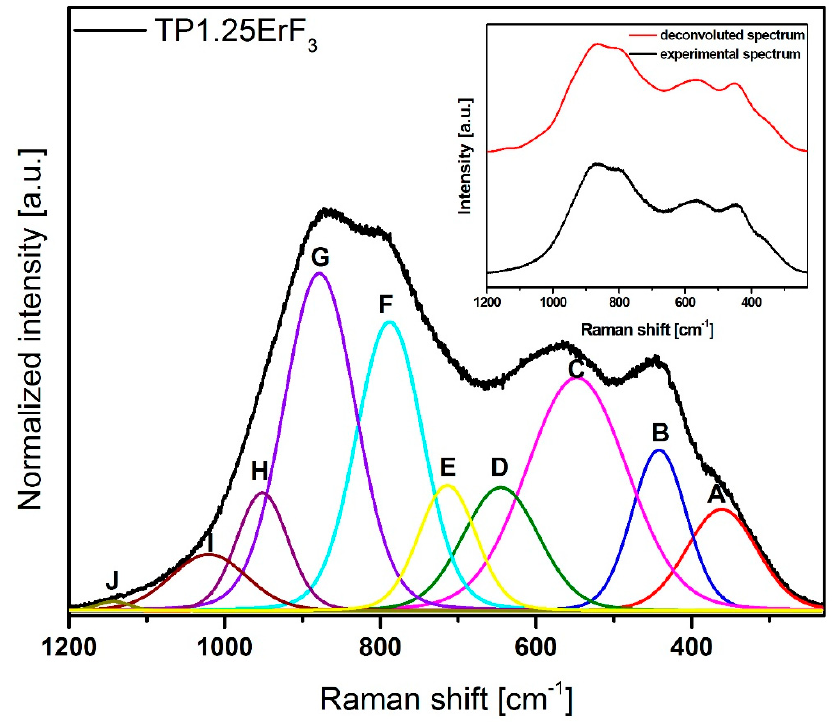
Figure 11. Deconvoluted Raman spectra of TP1.25ErF 3 glass. (inset) Deconvoluted and experimental spectra.